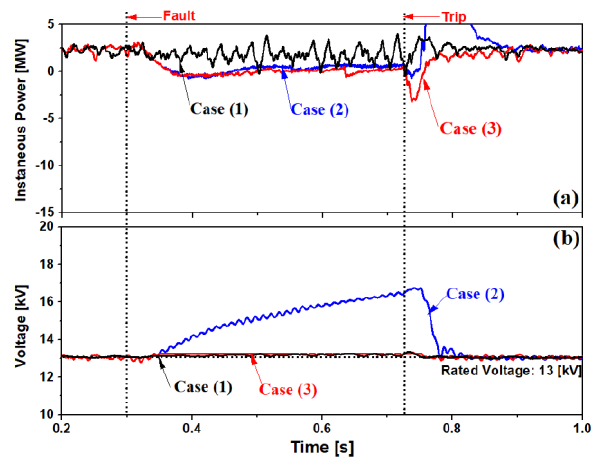
Figure 13. Simulation Results in Case (1)–(3): ( a ) Instantaneous Power of VSC (Voltage Sourced Converter); ( b ) DC Link Voltage.